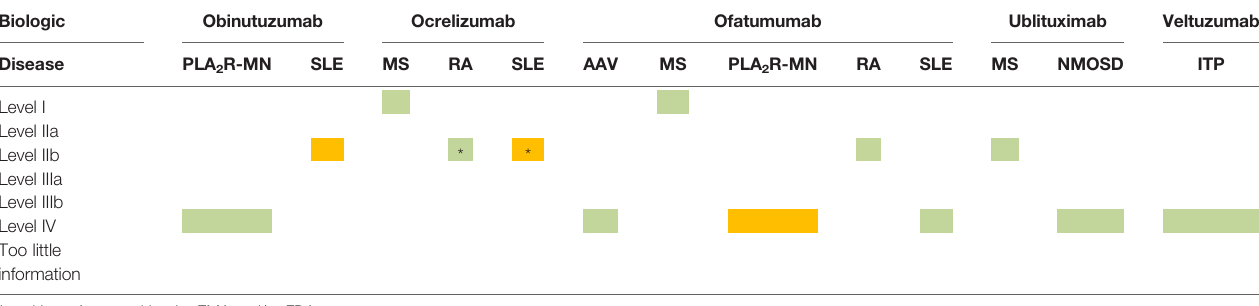
TABLE 4 | Summary of the